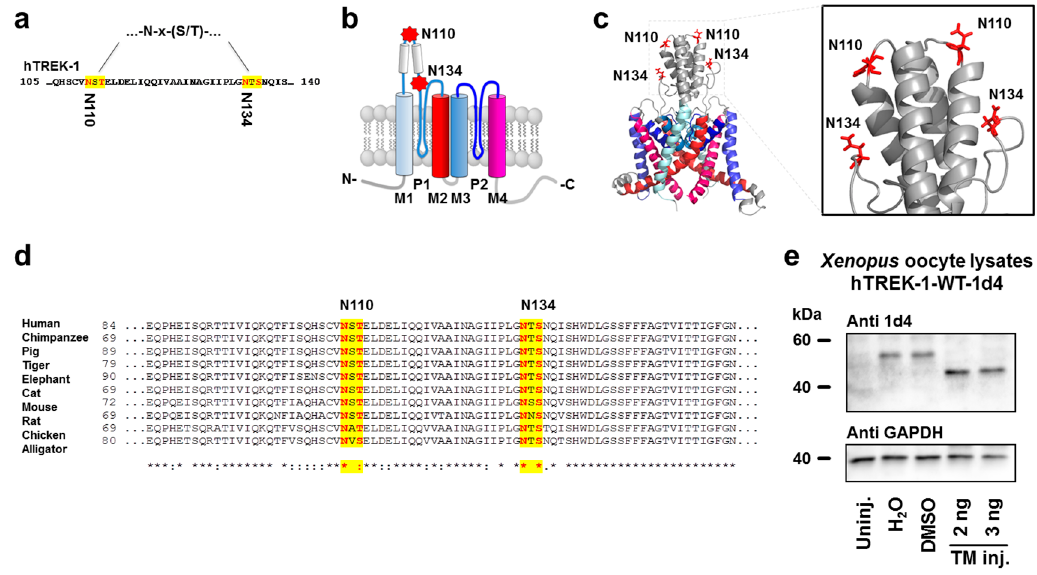
Figure 1. hTREK-1 channels harbor two putative N -glycosylation sites. ( a ) Two potential N -glycosylation consensus sites (yellow), consisting of an asparagine residue (N, red) followed by any amino acid except proline (x) and a serine or threonine residue (S/T, red) can be found in the extracellular part of the hTREK- 1 amino acid sequence. Asparagine residues possibly modified by carbohydrates are located in positions